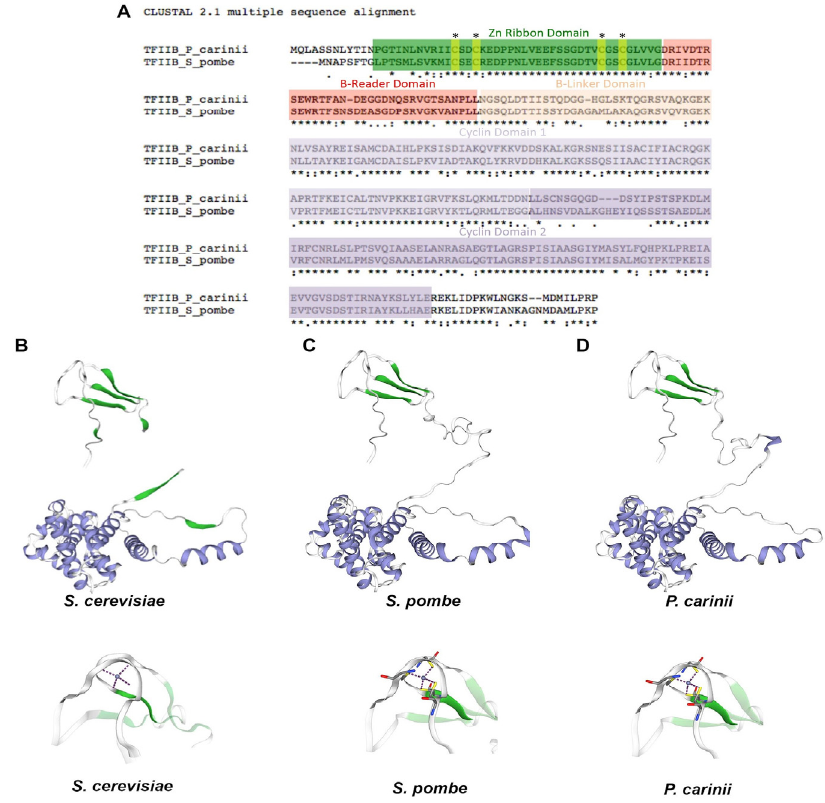
Figure 1. P. carinii TFIIB protein has highly conserved regions. ( A ) Comparison of TFIIB amino acid sequences from P. carinii and S. pombe (fission yeast) TFIIB. In colors are highlighted the known TFIIB domains and names are given over each domain. The alignment was performed with the ClustalW program (https://www.genome.jp/tools-bin/clustalw, accessed on 21 March 2022). ( B ) 3D structure of TFIIB from S. cerevisiae , which was the template to generate structures of panels C and D. ( C , D ) Predicted 3D structures of TFIIB from S. pombe and P. carinii were determined using the online tool Structure homology-modeling (https://swissmodel.expasy.org, accessed on 30 May 2022) using as a template the crystal structure information of budding yeast TFIIB. In the 3D structures, the Zn-ribbon domain is highlighted in green and cyclin domains are highlighted in purple. Bottom panels show a modeling of the Zn-ribbon domain of S. cerevisiae , fission yeast and P. carinii TFIIB that shows the Zn ion (blue) coordinated by cysteine residues